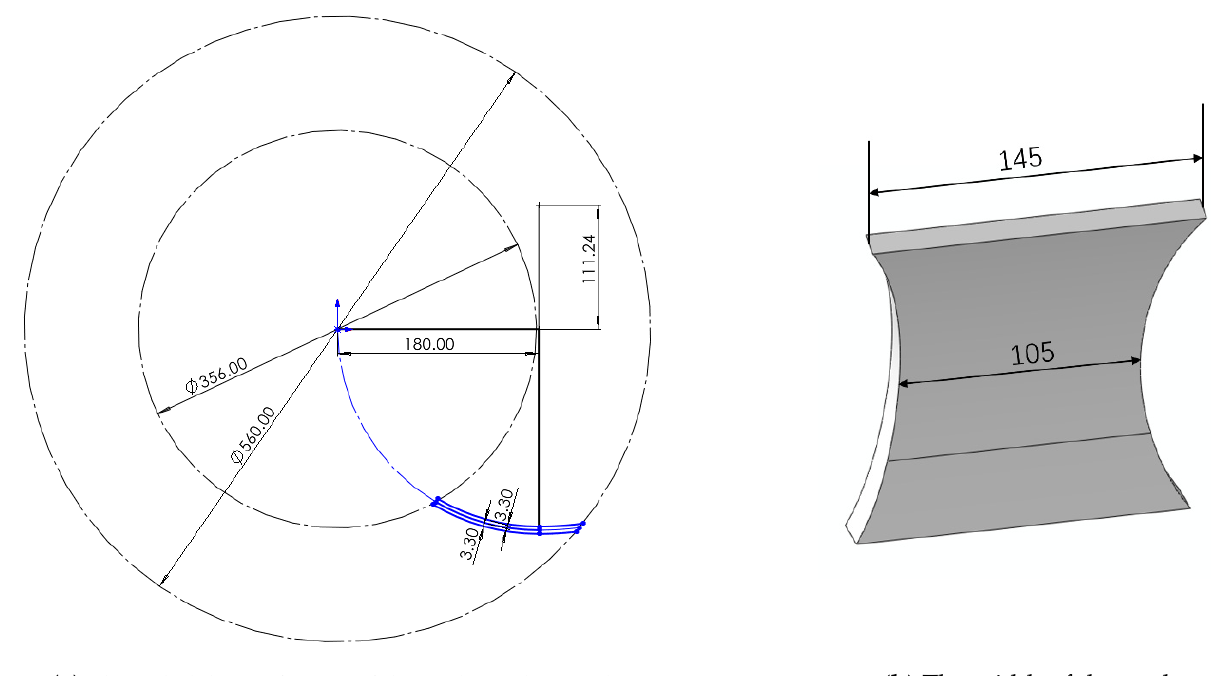
Figure 2. The radial design feature of the spoke in a 2D plane of the FS-NPT.